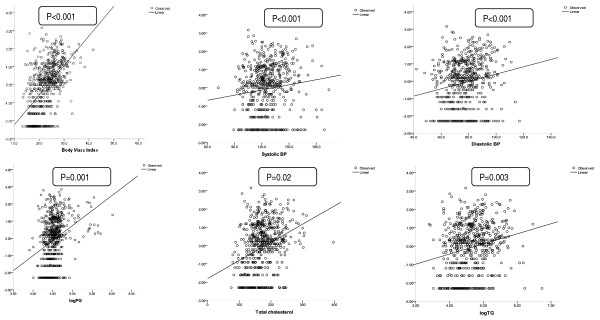
Association between CRP concentration and conventional risk factors of CVD (regression lines). X axis, Loge of CRP; BP, blood pressure; PG, plasma glucose; TAG, triglycerides